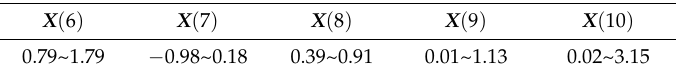
Table 3. The search space of X ( 6 : 10 ) defined by RLS.